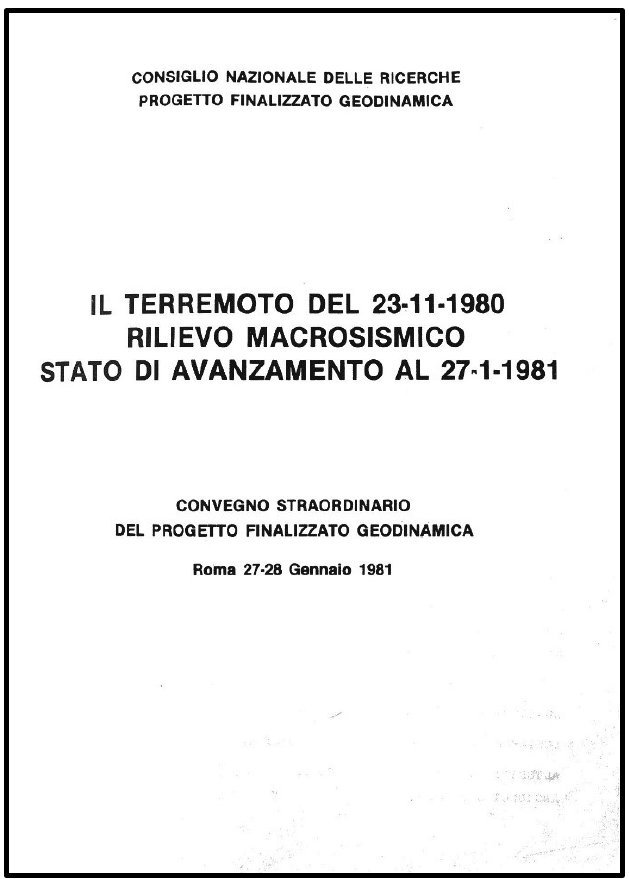
Figure 4. First macroseismic study published about two months after the 23 November 1980, earth- quake (January 1981), showing preliminary intensity assessment by PFG researchers [29]. In particular, during the emergency activity for urban reconstruction, preliminary seismic microzonation studies were carried out in collaboration with the Tuscany and Emilia-Romagna regions, involving 39 towns in the epicentral area of Campania and Basili- cata, with the objective of providing technical maps, on a scale of 1:5000, with indications of areas with different geological characteristics and the most suitable areas for recon- struction [35]. Other two important publications edited by the CNR- PFG in the field of seismology were certainly the Atlas of Isoseismal maps of Italian Earthquakes, and the first modern Italian Seismic Catalogue (Figure 8)